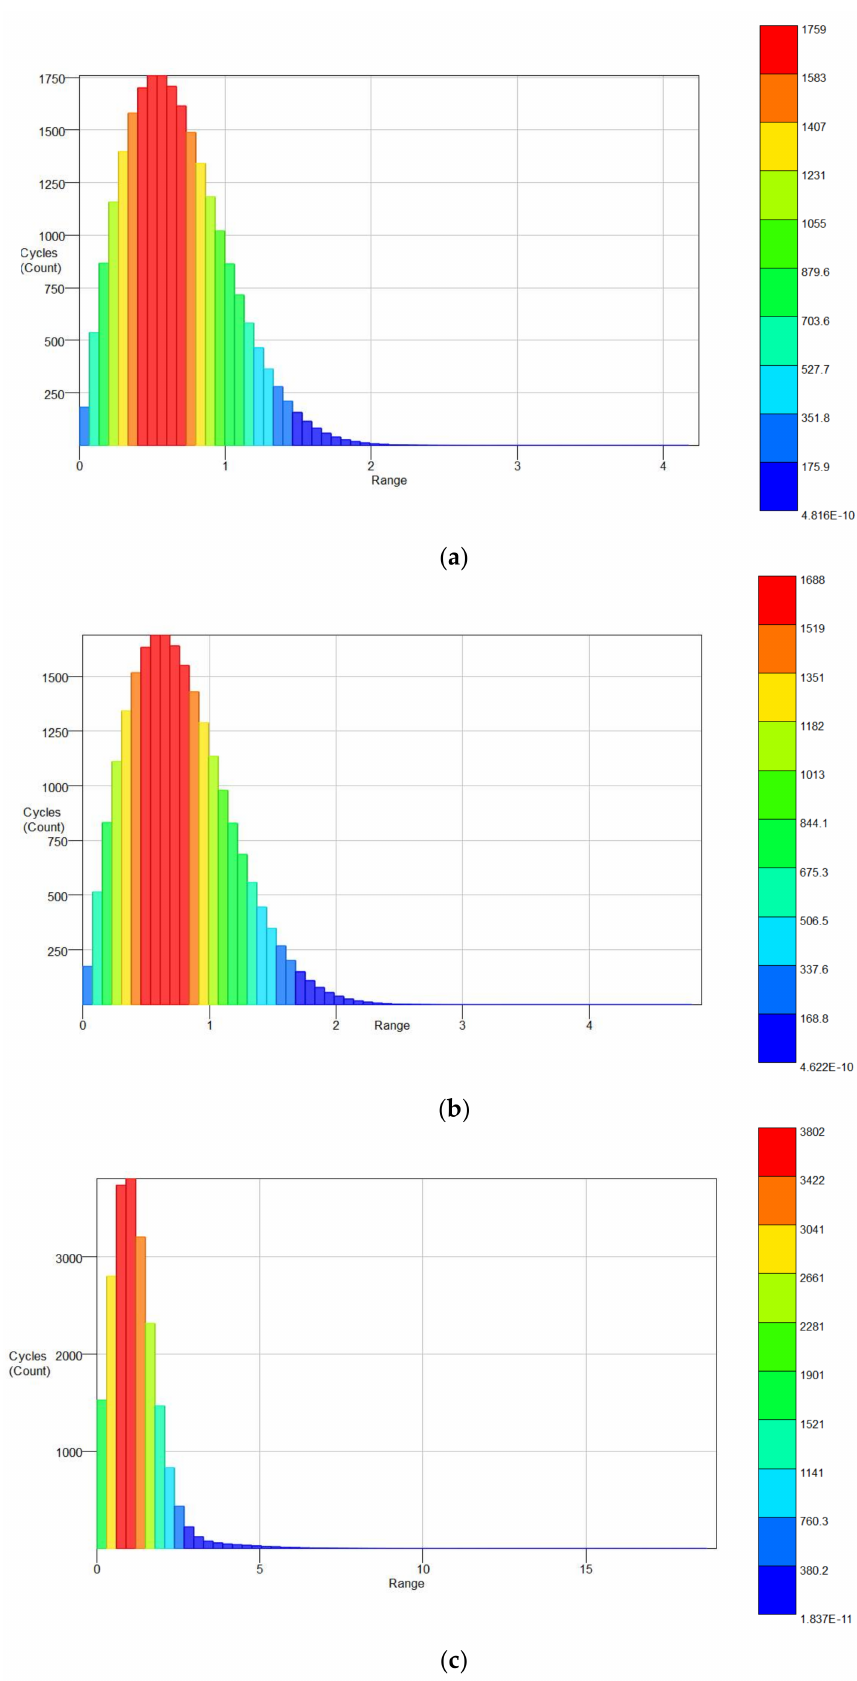
Figure 10. Narrow band PSD cycle count for different roads: ( a ) highway; ( b ) residential; and, ( c )